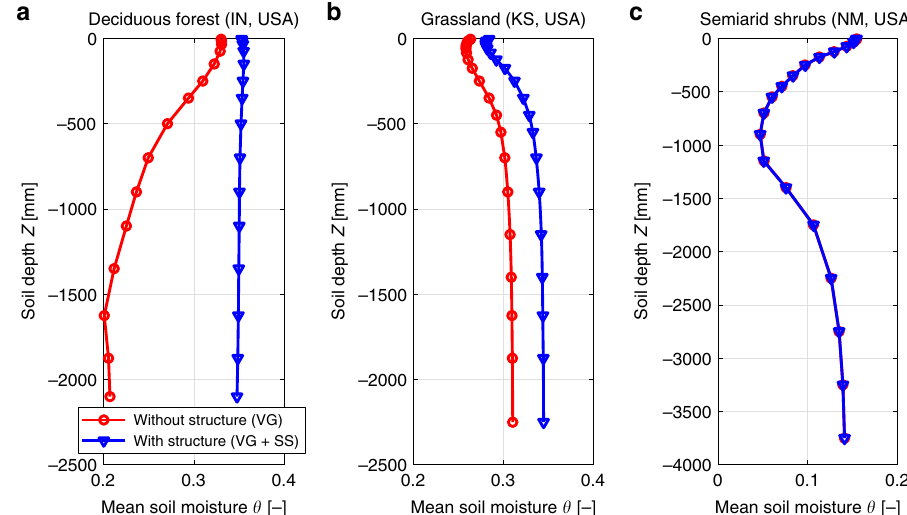
Fig. 4 Changes in vertical pro fi les of soil moisture. Long-term averaged soil moisture ( θ ) pro fi le with soil depth for the scenario VG and scenario VG + SS. Results correspond to simulations with T&C at the locations of Morgan Monroe Deciduous Forest ( a ), Konza Prairie Grassland ( b ), and Jornada Semi-arid shrub site ( c